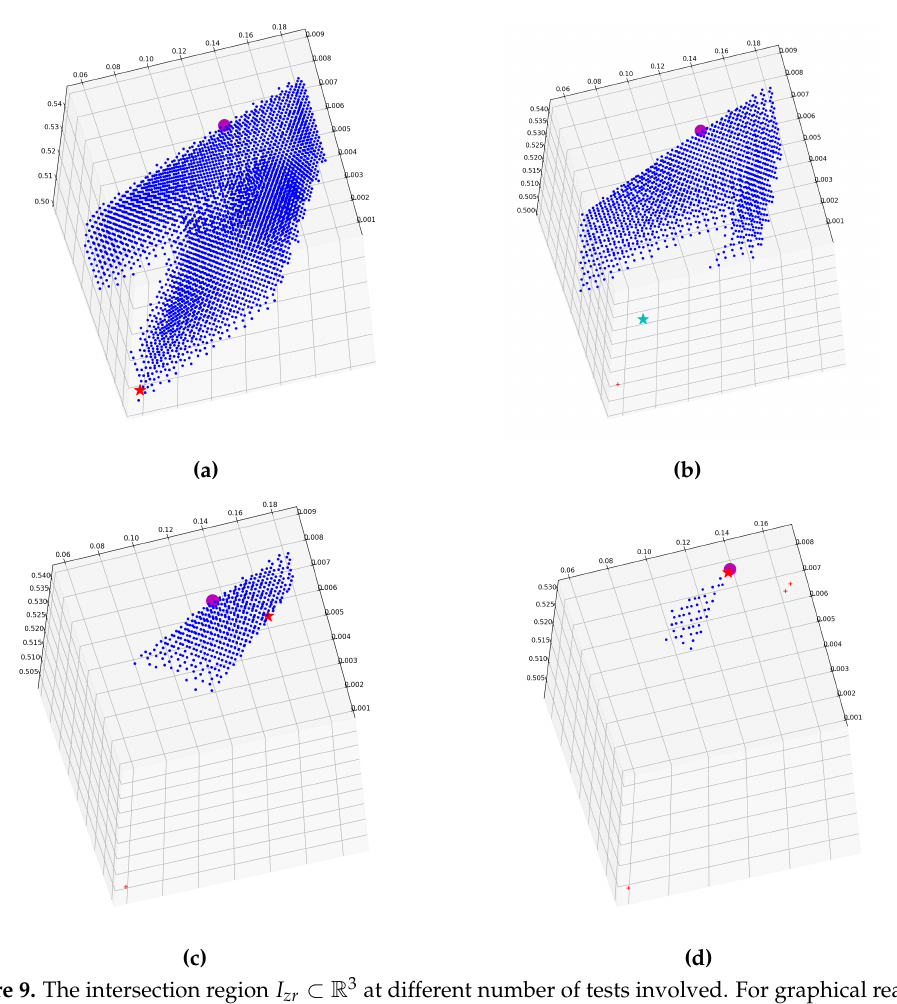
Figure 9. The intersection region I zr ⊂ R 3 at different number of tests involved. For graphical reasons the region has been discretized and the dots are the grid nodes; the bigger ball is the true solution and the star is the current estimate in the experiment. ( a ) 3 tests; ( b ) 5 tests; ( c ) 9 tests; ( d ) 20 tests.